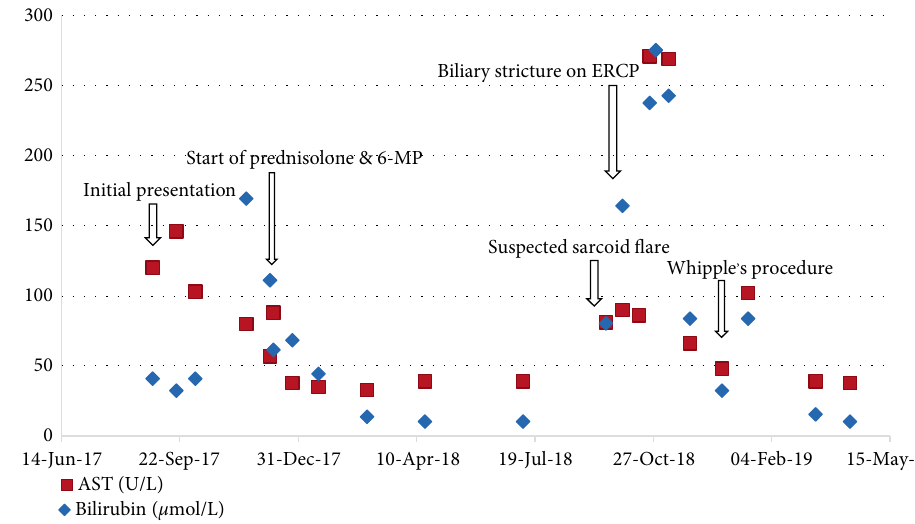
Figure 1: Bilirubin and ALT trend in relation to patient’s diagnosis and treatment.